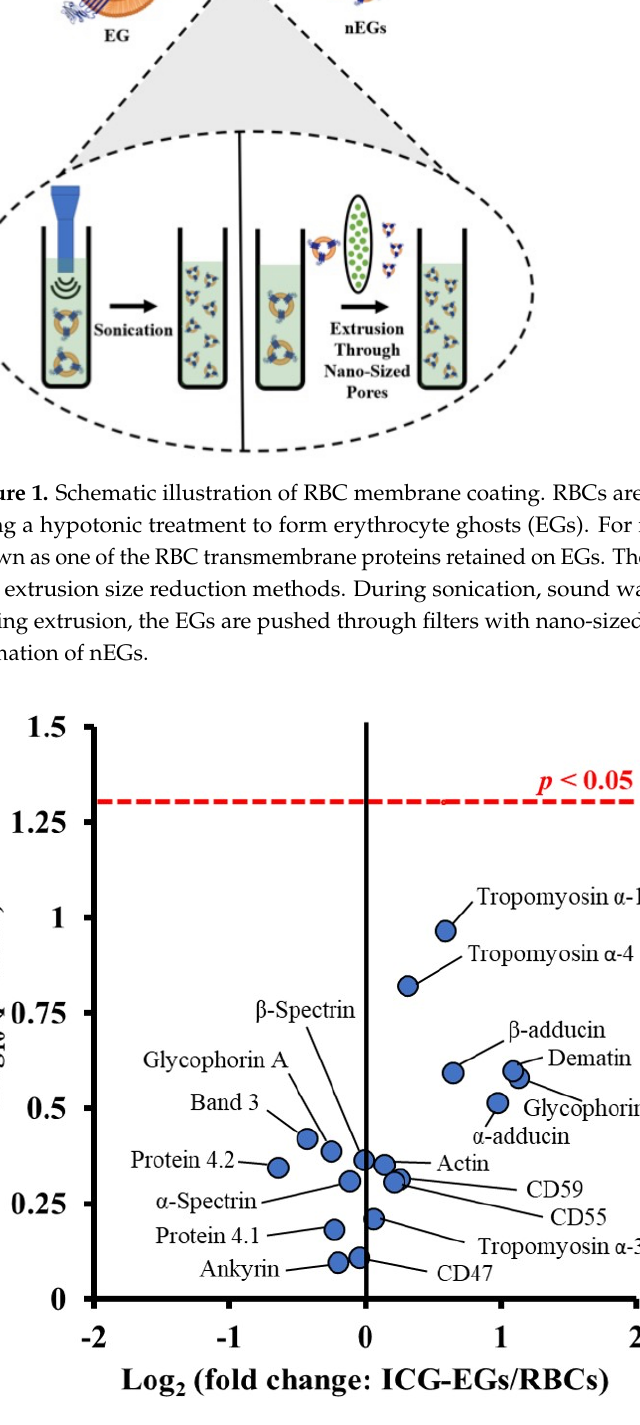
Figure 2. Volcano plot associated with proteomics analysis of human RBCs, and ICG-EGs. Each dot represents a particular protein. There are no statistically significant differences in the ratios of ICG-EGs proteins to RBCs proteins located below the red dashed line.